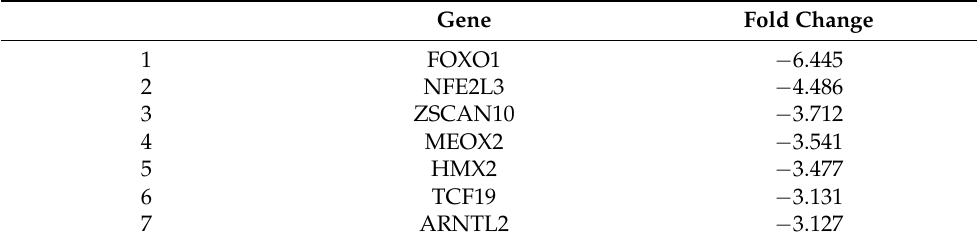
Table 7. Genes in the transcription factor category that are downregulated in neural cells. Gene Fold Change 1 FOXO1 −